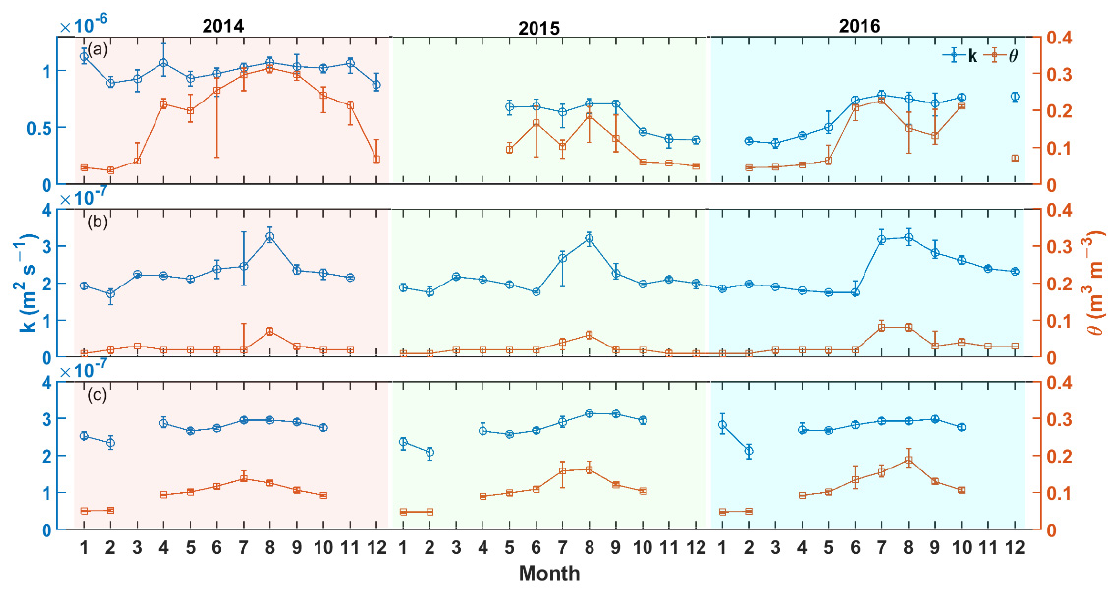
Figure 5. The monthly variations (25th, median, and 75th percentiles) of soil apparent thermal diffusivity (k, m 2 s − 1 ) and moisture ( θ , m 3 m − 3 ) at ( a ) BJ, ( b ) QOMS, and ( c ) NADORS for 2014–2016. Data are deleted when there are less than 15 days available in a month. Table 3. The monthly (mean ± one standard deviation) k × 10 7 (m 2 s − 1 ) at each site. BJ QOMS Month